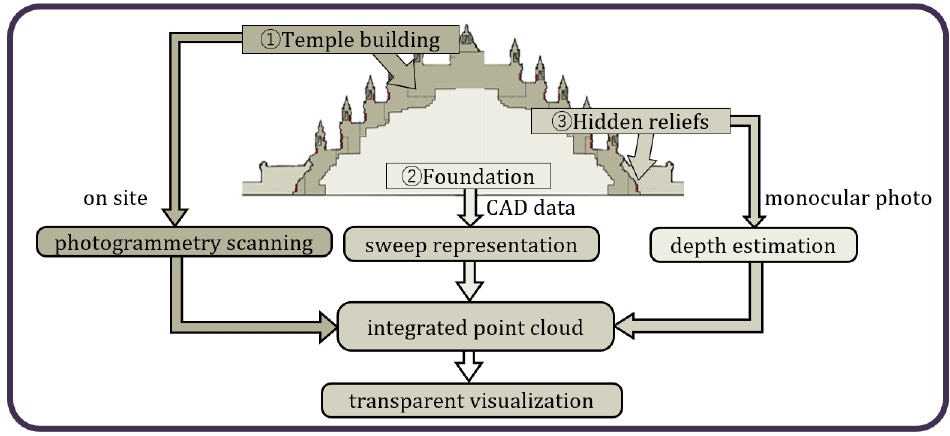
Figure 2. The overall strategy of the integrated transparent